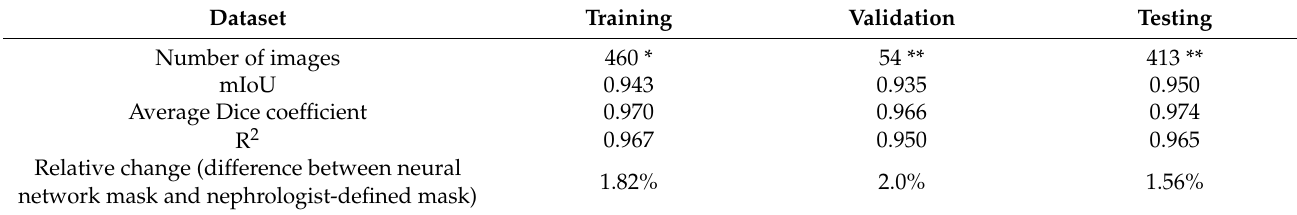
Table 2. Automatic segmentation and CTR calculation performance. mIoUs are calculated with the mask predicted by the neural network and the mask marked by the nephrologists; Dice coefficients are calculated with the mask predicted by the neural network and the mask marked by the nephrologists; R 2 represents the correlations between the CTR predicted by the neural network and the CTR marked by the nephrologists with linear regression; relative changes represent the difference between the CTR predicted by the neural network and the CTR marked by the nephrologists.